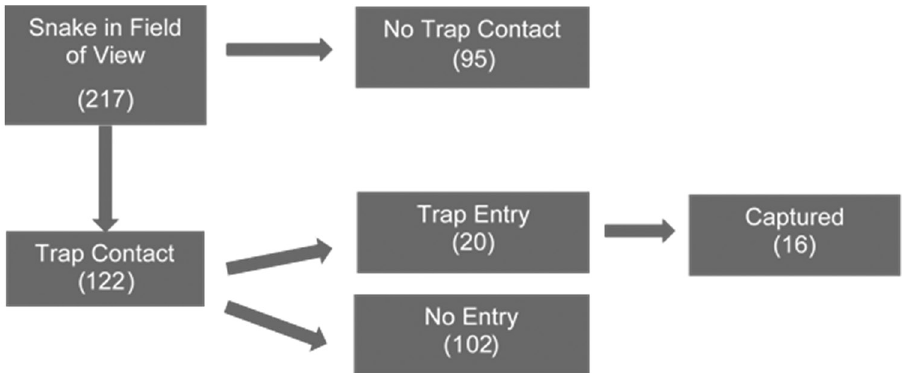
Figure 3. Schematic of brown treesnake activity outcomes at bird-lure camera traps ( n = 8). A portion of snake observations were probably repeated instances of one snake’s efforts to capture the prey (e.g., brief absence and return to field of view in close spatial proximity to departure location and similar physical attributes [broken tail, size]) and were therefore counted as a single snake event. Trap contact consisted of the snake making physical contact with the trap. Trap entry consisted of snakes using either entrance to enter the trap. Values listed parenthetically represent the number of snakes for a specified outcome, with snakes captured in traps being the desired outcome for